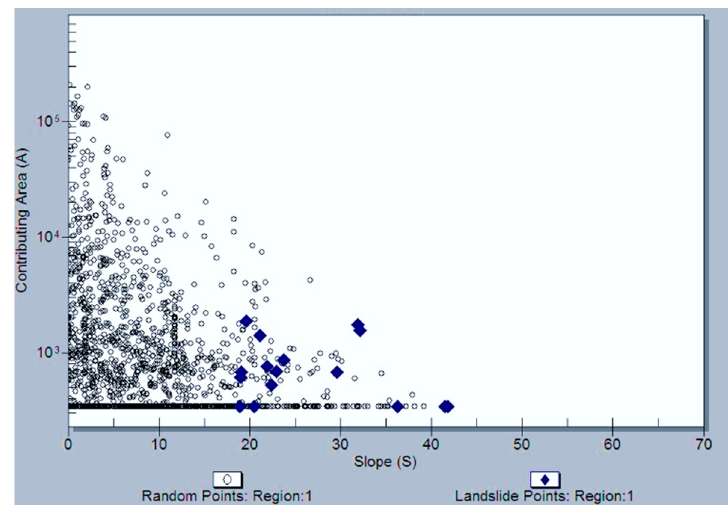
Figure 4. Graph of the slope-area (S–A) of Buleleng. Table 2. Results of soil investigation.